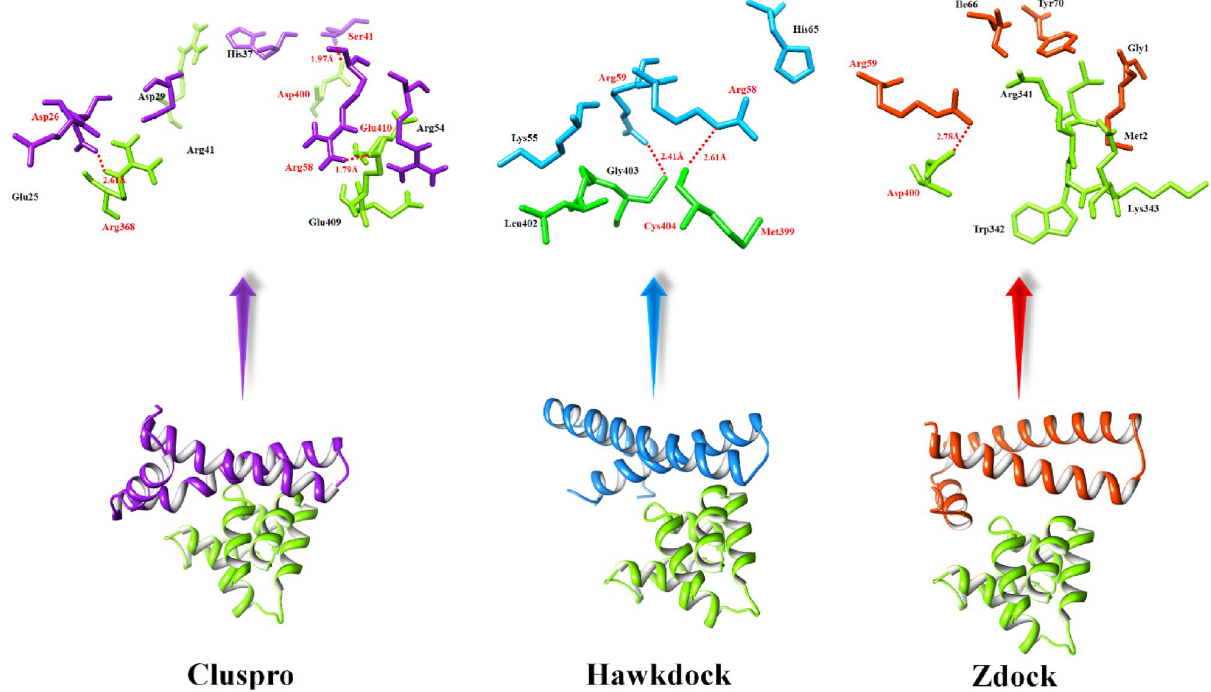
Figure 7. Docking interactions between DDs of TNFR1 and MADD. The surface structure of TNFRA1 is highlighted in green color whereas, MADD is justified in three different colors like purple, blue and orange-red, respectively. The red dotted lines represent hydrogen bond distances in angstrom (Å).